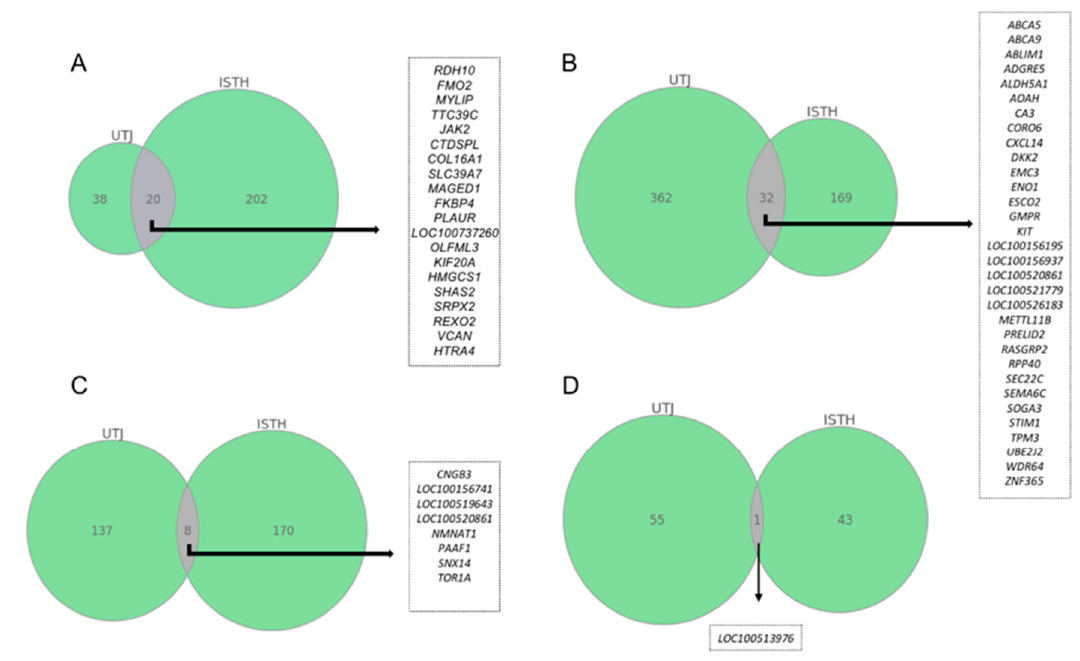
Figure 2. Venn diagram showing common altered genes among tissues within each treatment. Analysis of commonly altered transcripts among oviduct segments (UTJ: Utero-tubal junction; Isth: Isthmus;) after mating (( A ); FDR < 0.05); artificial insemination from the sperm-peak ejaculate portion: P1-AI (( B ); p < 0.01); exposure to seminal plasma from the sperm-peak ejaculate portion: SP-P1 (( C ); p < 0.01); exposure to seminal plasma from the entire ejaculate: SP-Ejac (( D ); p < 0.01). The numbers of genes altered in common are indicated at the intersections of the circles in the Venn diagram.